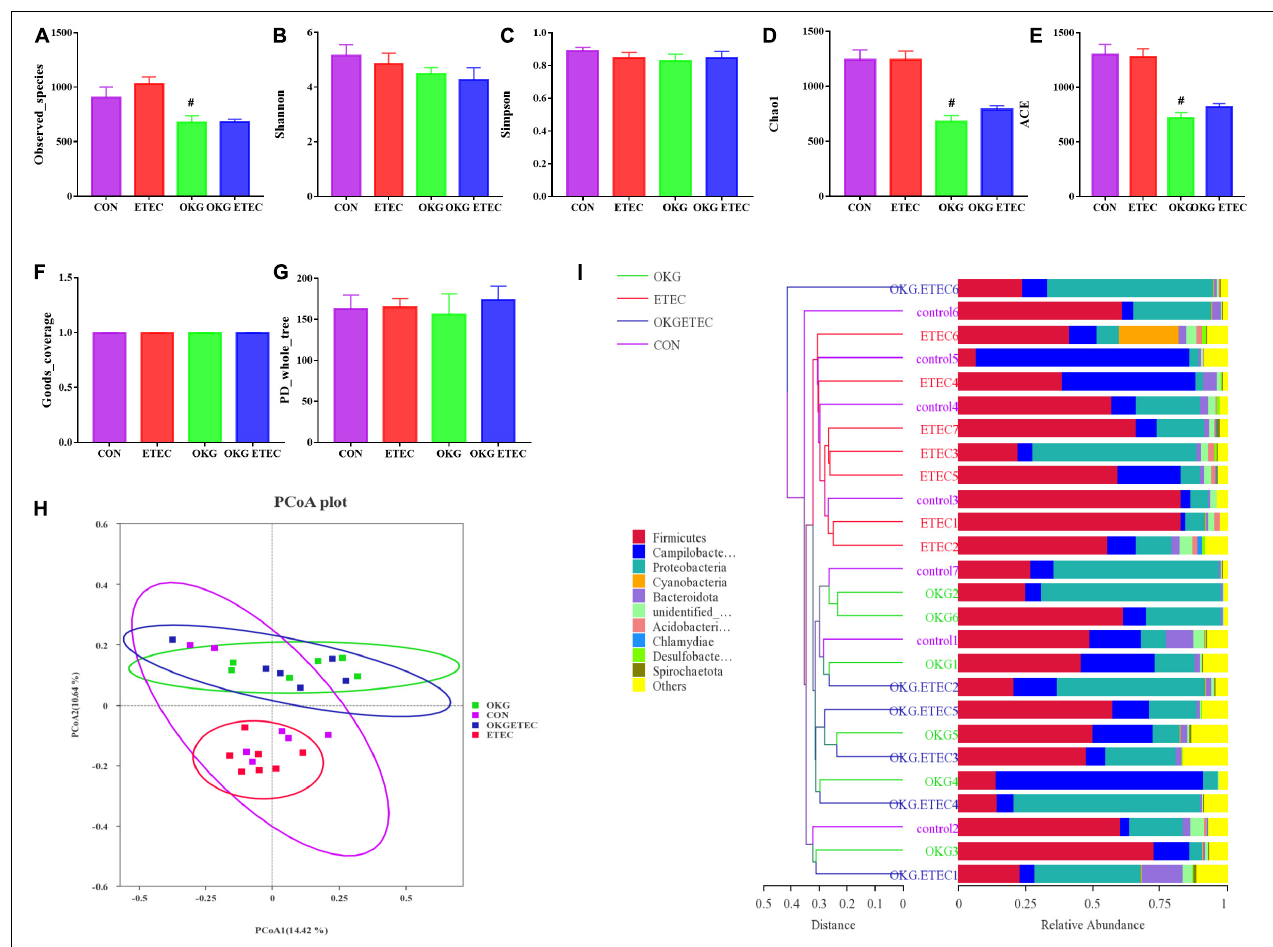
FIGURE 2 | Effects of OKG supplementation on ileal mucosa microbiota diversity in ETEC- infected pigs. (A–G) α -diversity analysis, (H) PCoA plot analysis from each sample, (I) weighted UniFrac distance in each sample. Values are presented as mean ± SEM. *Indicates a statistically significant difference for the challenge (ETEC or LB Broth) ( p < 0.05). # Indicates a statistically significant difference for dietary treatment (basal or OKG diet) ( p <